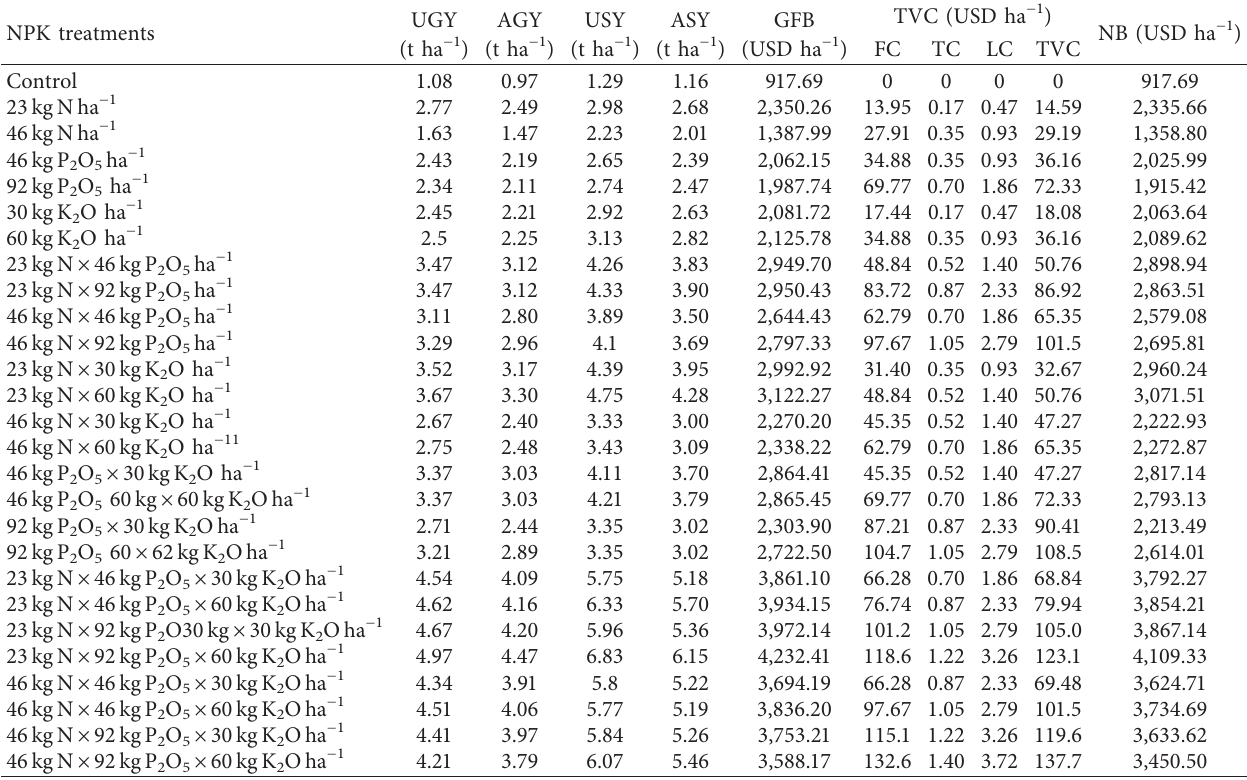
Table 10: Partial budget analysis of faba bean influenced by mineral nitrogen, phosphorus, and potassium fertilizers. UGY AGY NPK treatments